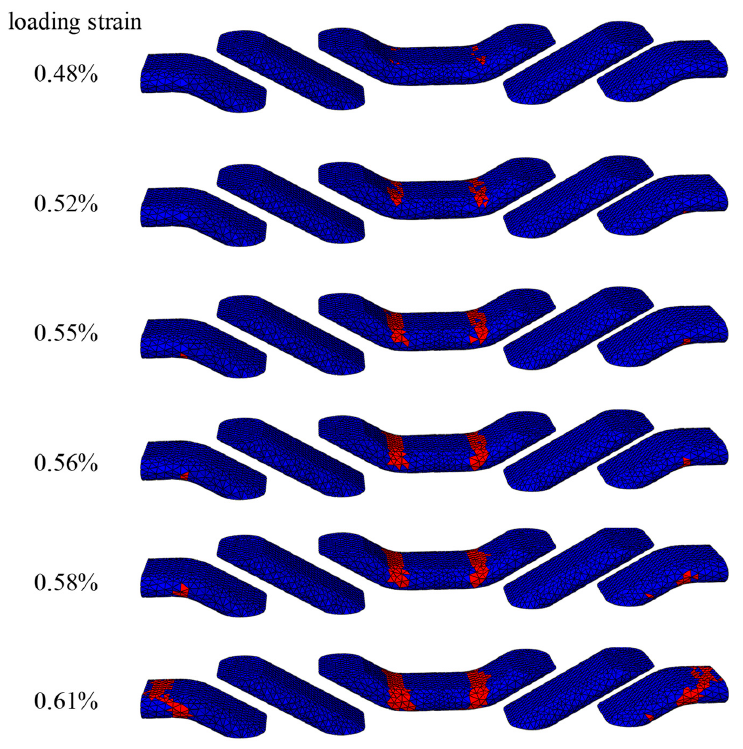
Figure 5. Warp yarn full damage contour predicted by the FE model at different loading levels, red color indicates full damage, defined as Equation (7) is greater than 0.9.